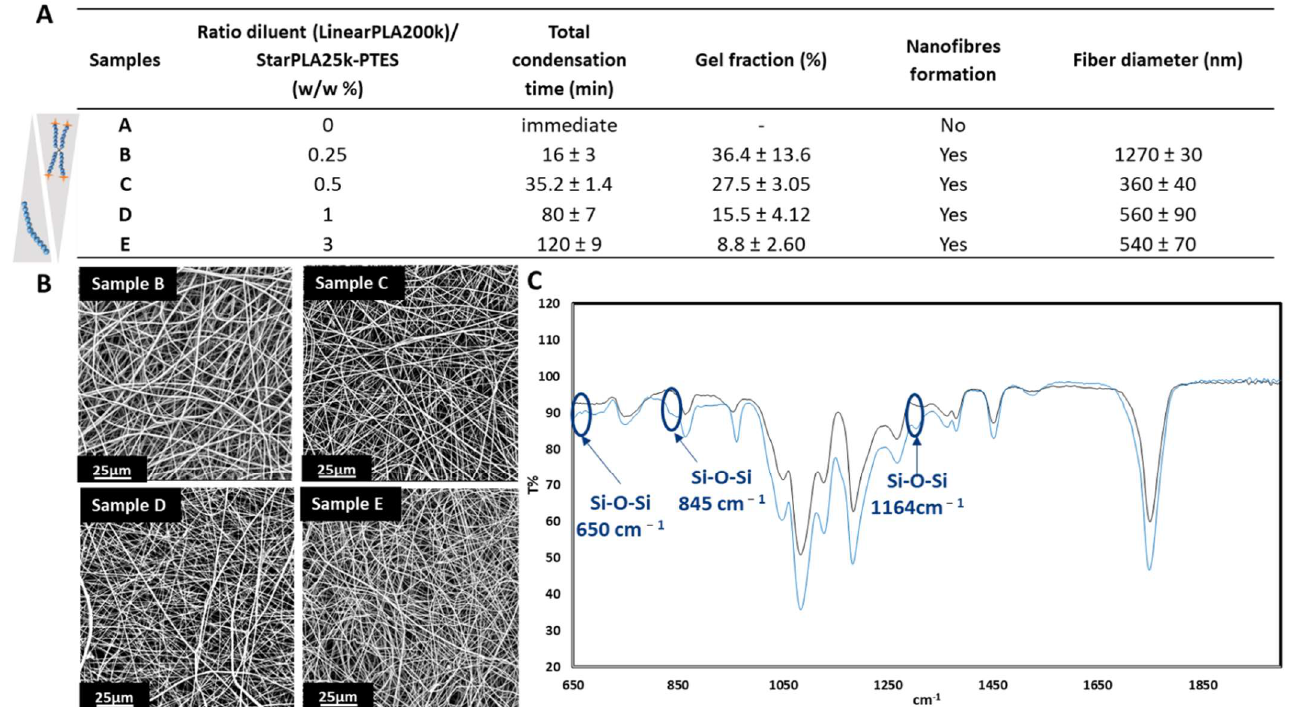
Figure 2. Crosslinking of nanofibers during electrospinning: ( A ) Polymer solution total condensation time, nanofibers gel fraction and fiber diameter; ( B ) SEM images of samples B, C, D and E; ( C ) FT-IR analysis of sample C without and with activation of the sol-gel reaction.